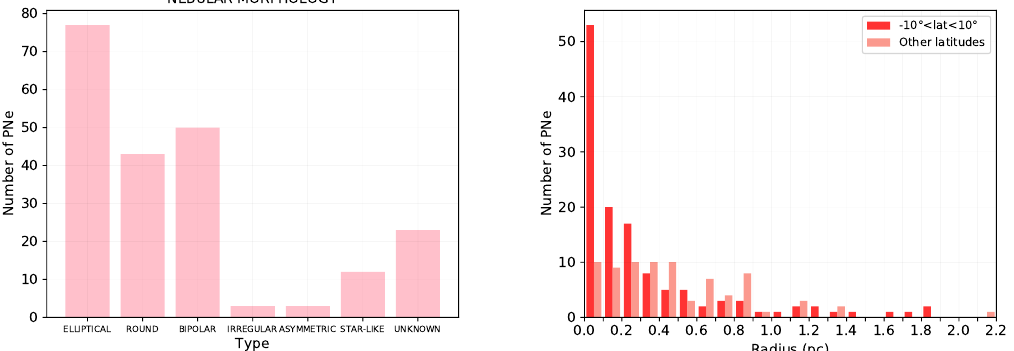
Figure 2. Morphological classification ( left ) and radii distribution separated in low latitudes and other latitudes ( right